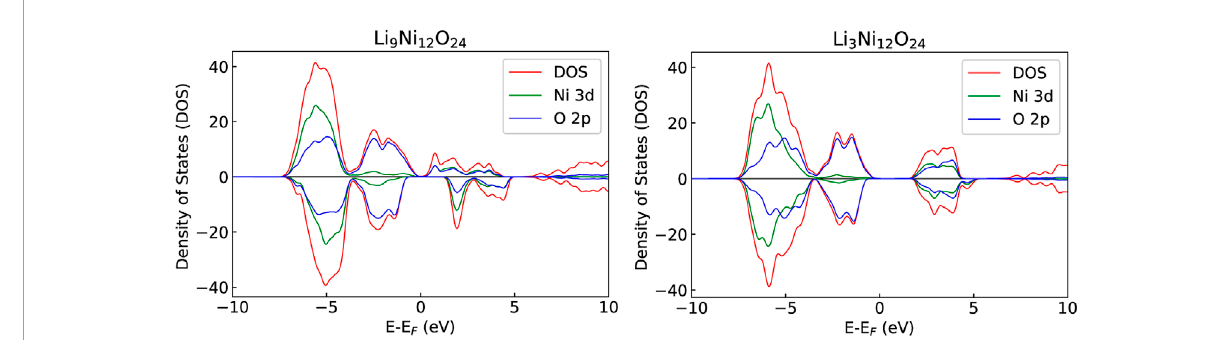
FIGURE 4 The partial and total DOSes of Li x NiO 2 with x = 0.75 (left) and 0.25 (right). The overlap between Ni d -bands and O p -bands is more pronounced upon delithiation, as expected.